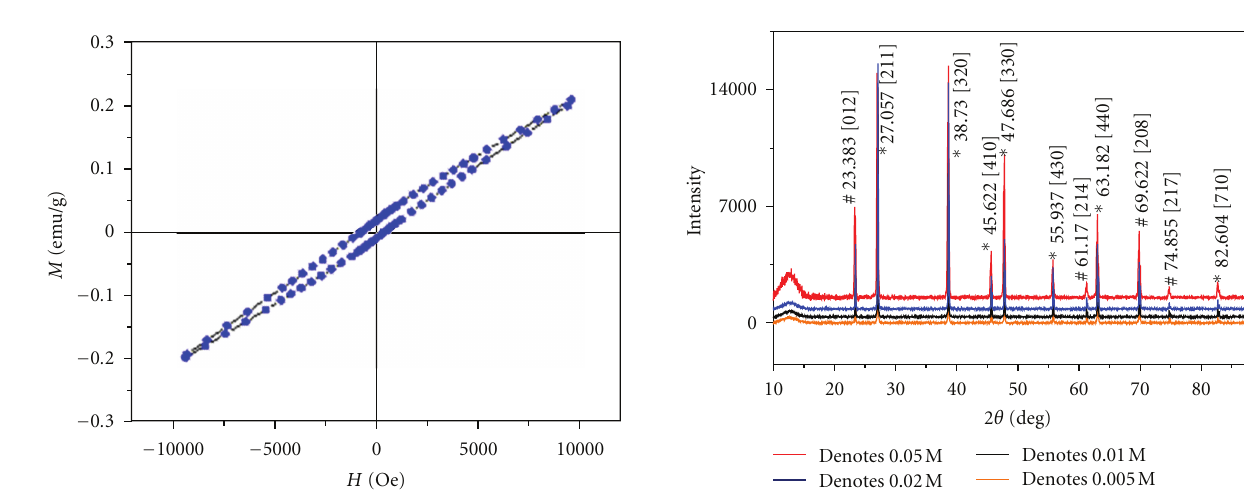
Figure 2: VSM measurements for γ -Fe 2 O 3 nanoparticles. Figure 3: XRD patterns of synthesized γ -Fe 2 O 3 nanoparticles with di ff erent concentrations of FeCl 3